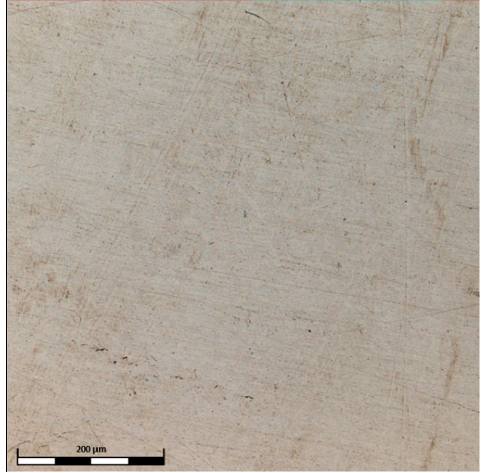
Figure 12. Confocal image of the 316L steel surface after corrosion test.